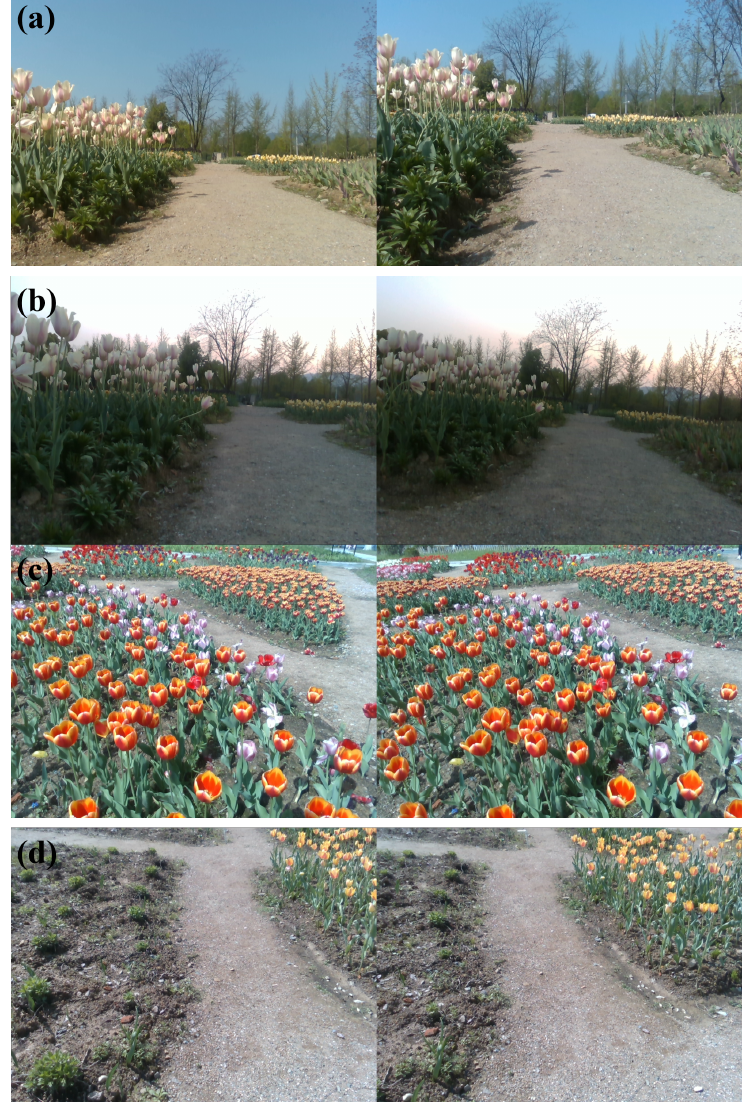
Figure 14. Experimental images under different scenes: ( a ) Normal light scene; ( b ) weak light scene; ( c ) high texture scene; ( d ) low texture scene.